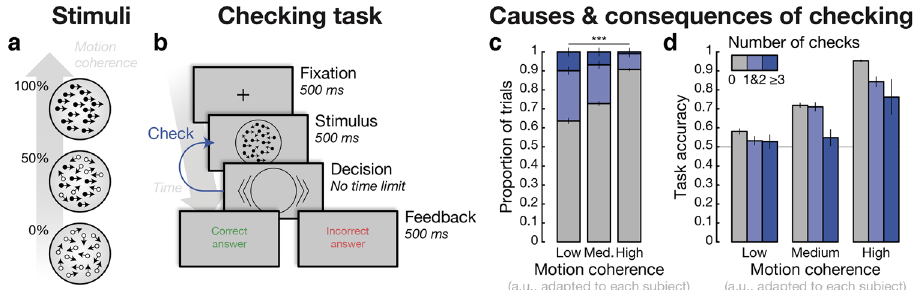
Figure 1. Causes and consequences of checking behavior. ( a ) RDℳ stimuli . Stimuli used throughout the study were random dot motion (RDM) stimuli whose coherence level was manipulated. Participants were asked to judge the direction of motion (either left or right). ( b ) Checking task . Representative trial of the checking task: before committing to the decision, participants were allowed to replay the RDM stimulus an infinite number of times. Feedback was delivered at the end of the trial. ( c ) Increased checking after more difficult stimuli . Number of checks according to motion coherence (i.e. difficulty, in arbitrary units, a.u.), which is expressed in three terciles for the sake of averaging over participants (who have different perceptual sensitivity). ( d ) Decreased performance after checking. Accuracy of orientation judgments as a function of motion coherence and number of checks. Same binning method as in ( c ). Error bars correspond to standard error of the